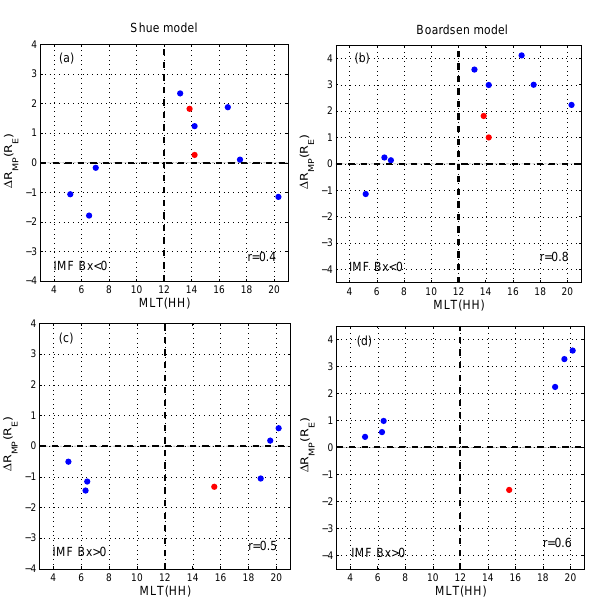
Figure 4. The MLT variation in the differences in the magnetopause locations at midlatitudes ( (cid:49)R MP ) observed by Cluster and pre- dicted by the Shue98 model (left panels) and the Boardsen00 model (right panels). From top to bottom, the figure shows earthward and sunward IMF events. A positive value means that the observed mag- netopause is located further outward than the model prediction, and negative values mean the opposite. Red (blue) colors indicate north- ern (southern) crossings. The correlation coefficients are